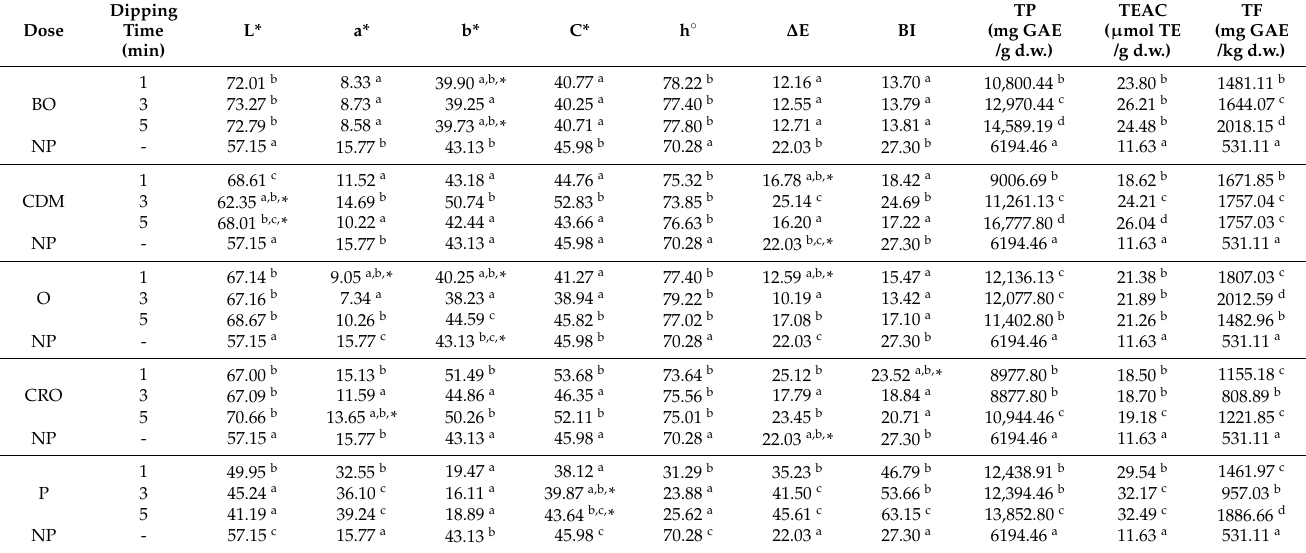
Table 3. Dipping Pre-treatment and Time Effect on Color and Bioactive Compounds